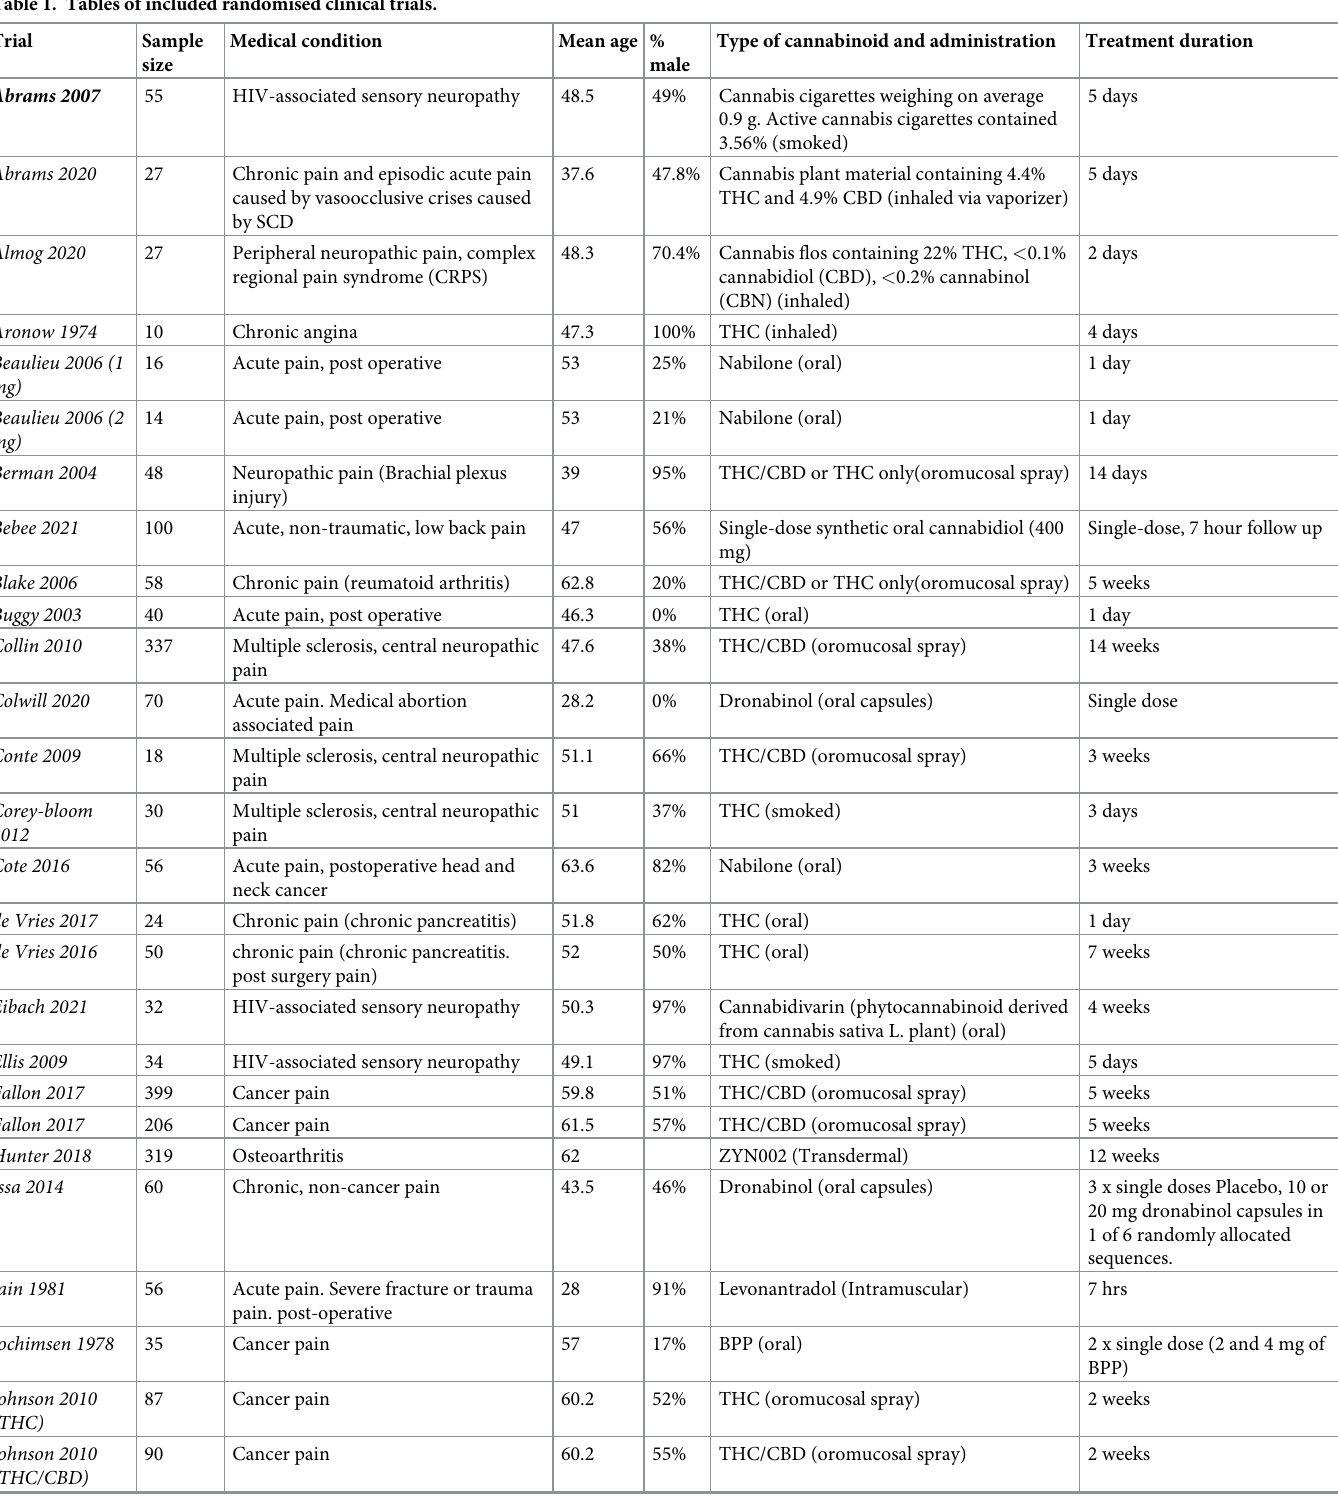
Table 1. Tables of included randomised clinical